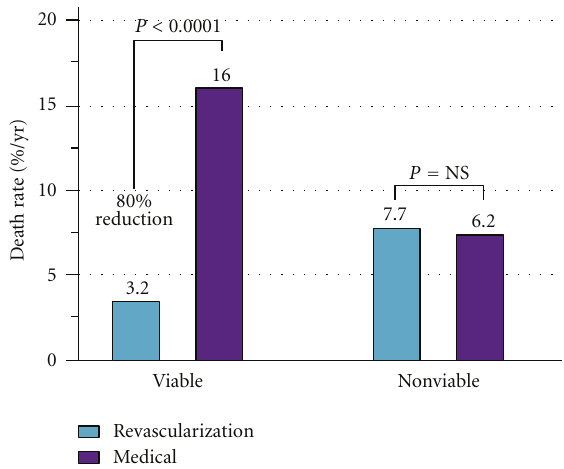
Figure 4: Analysis of pooled data from 24 studies using di ff erent viability techniques (with permission from Allman K et al (2002) J Am Coll Cardiol, Elsevier, Inc.,